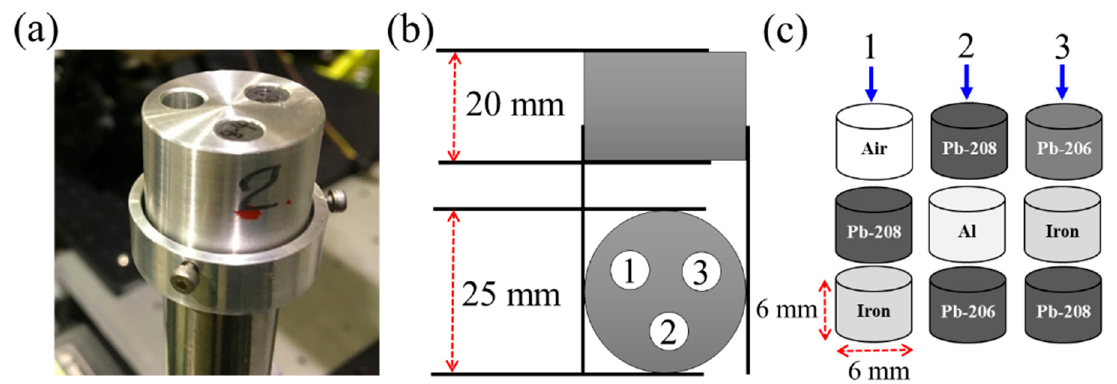
Figure 2. ( a ) Picture of the CT target. ( b ) Geometry of the CT target holder, having a diameter of 25 mm and a height of 20 mm. The target holder has three holes with equal diameters of 6.1 mm and a pitch angle of 120 ◦ . The numbering of the holes is shown on the target holder. ( c ) Arrangement of the rods, including the enriched lead isotope rods ( 206 Pb and 208 Pb), iron, aluminum, and a vacant area.